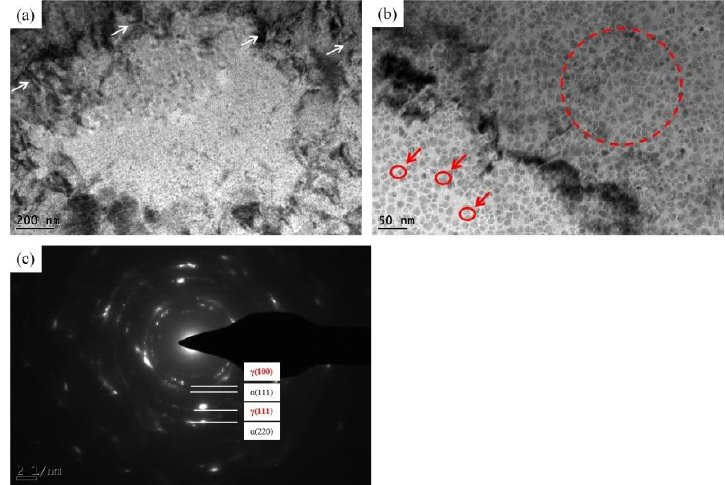
Figure 10. TEM micrograph of ( a ), ( b ) secondary particles in the cold-rolled samples, and ( c ) the SAED of the red dashed circle.